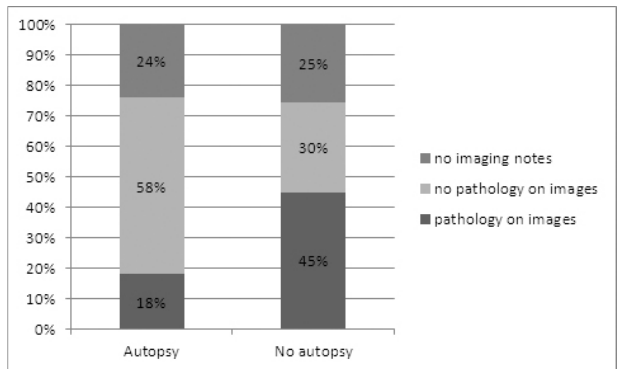
Fig. 2. Imaging findings for autopsied and non-autopsied cases; autopsies were performed on 121 cases; 71 cases were not